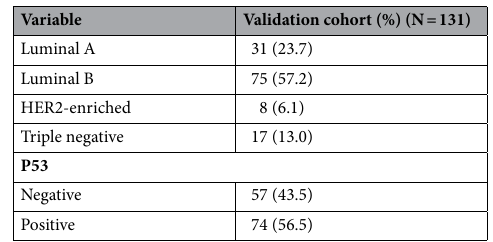
Table 2. Clinicopathological characteristics of the 131 patients in the validation cohort.